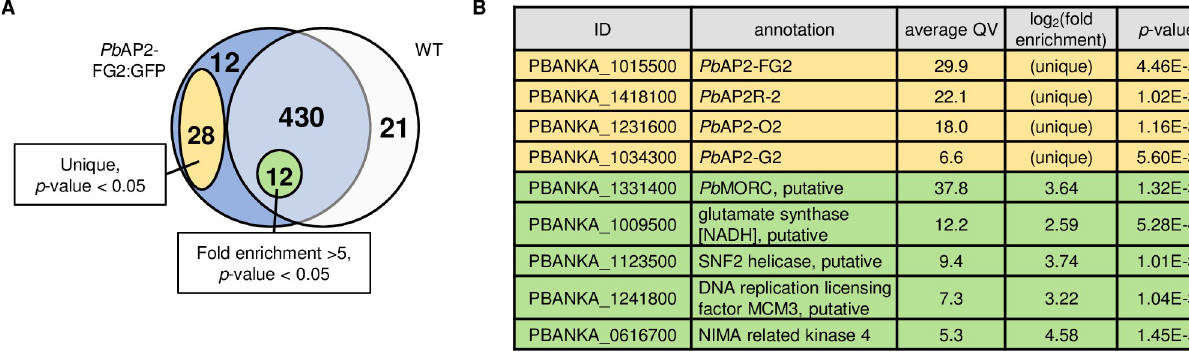
Fig 7. RIME using Pb AP2-FG2::GFP. (A) A Venn diagram showing the overlap between proteins detected in the RIME using Pb A2-FG2 and WT. Number of proteins that were unique and more than fivefold enriched with p -value < 0.05 in Pb AP2-FG2::GFP compared to WT was indicated in a yellow and green circle, respectively. (B) A list of possible interaction partners of Pb AP2-FG2 identified in the RIME. Those with average quantitative value > 5 for Pb AP2-FG2::GFP (average QV) are